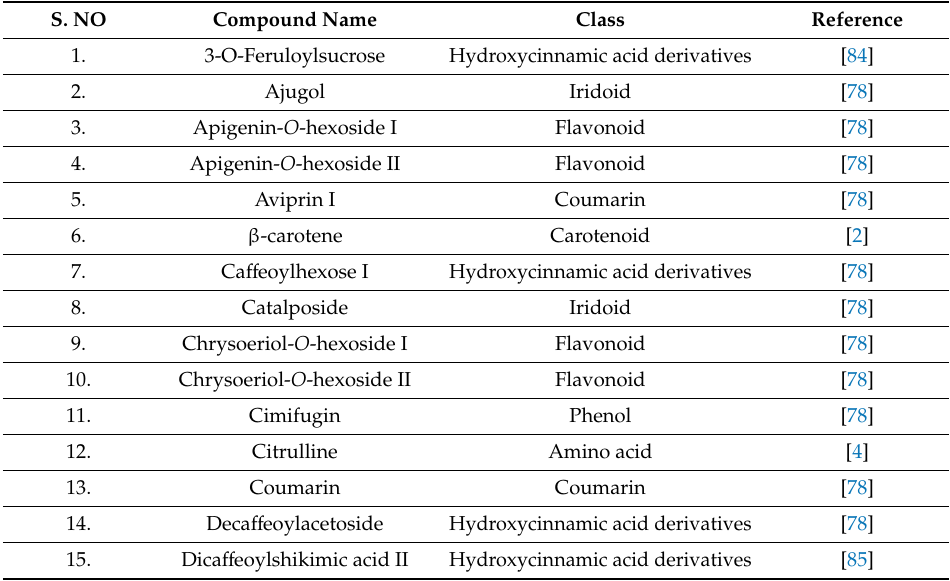
Table 1. Phytochemicals profiled in watermelon with antioxidant property. S.